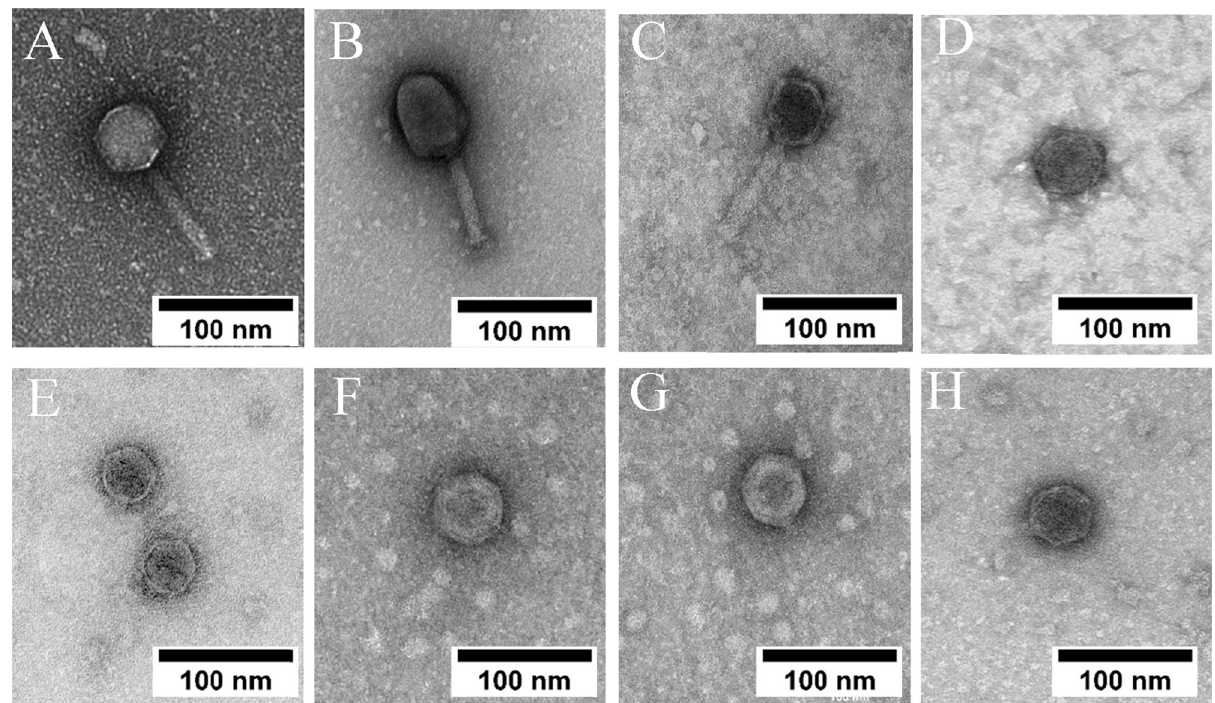
Fig. 1 Morphology of phage isolates examined via TEM. TEM images of E. coli K12 phages represented in the top panel ( A ) phage A1 ( B ) phage A2 ( C ) phage A6 and ( D ) phage A7. P. putida phages represented in the bottom panel ( E ) phage A8 ( F ) phage A9 ( G ) phage A10 and ( H ) phage A11.